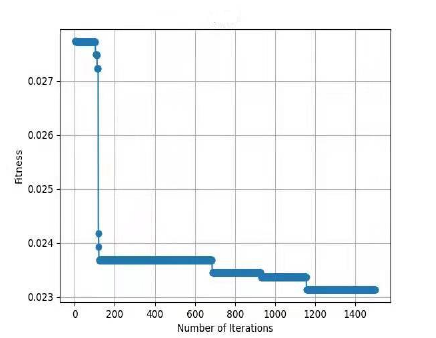
Figure 3. The fitness of